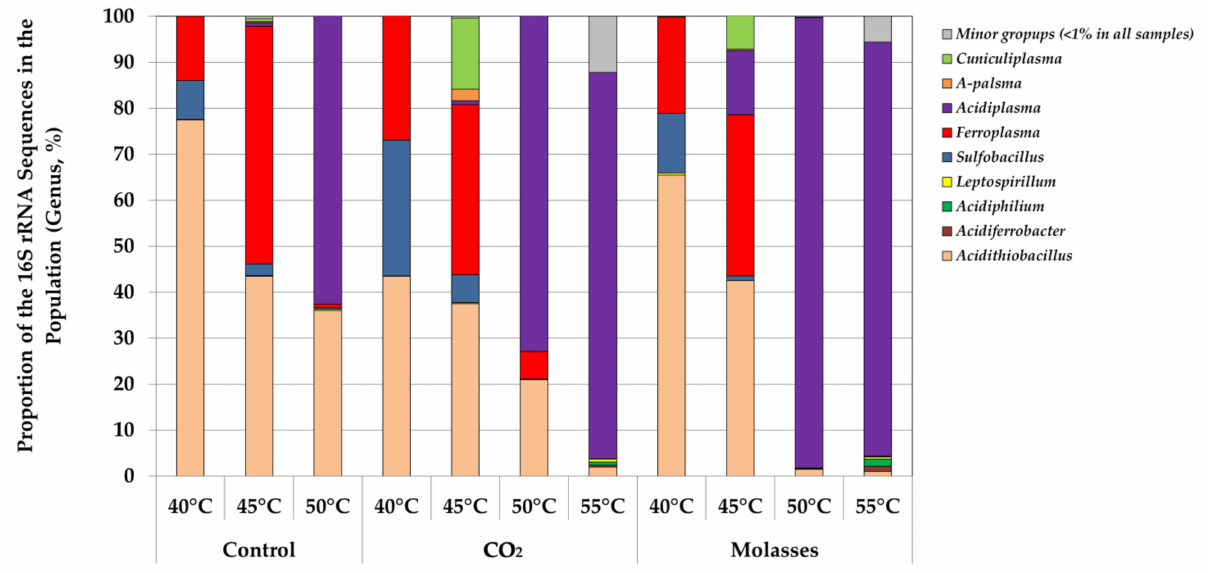
Figure 2. Analysis of microbial populations performing bioleaching under different conditions (proportion of the 16S rRNA gene